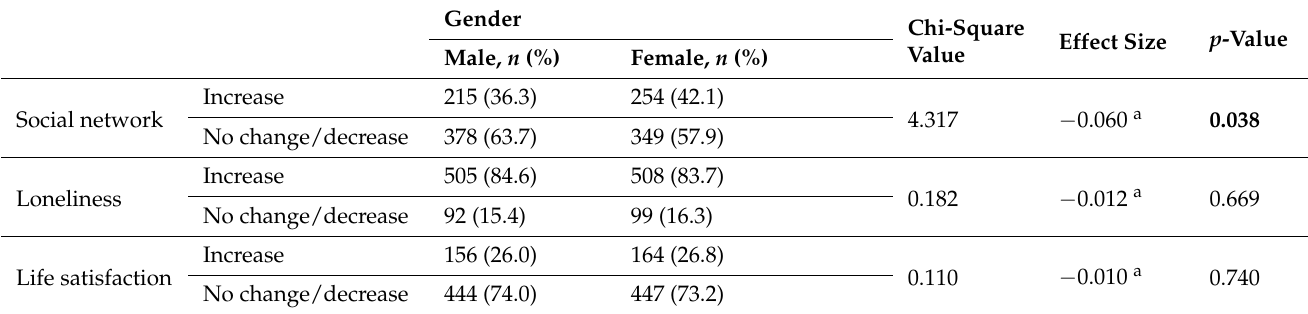
Table 2. Distribution of main study variables by gender and life